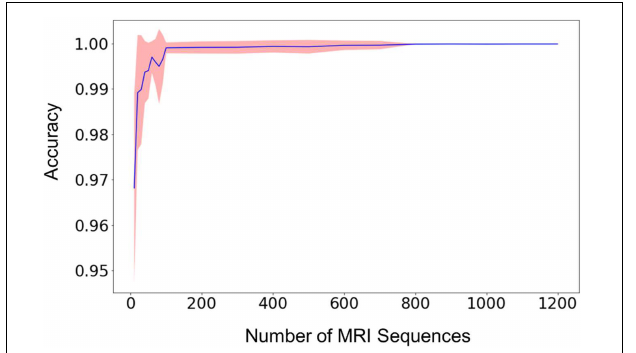
FIGURE 2 | The mean prediction accuracy (blue line) and standard deviation (shaded area around the blue line) of the random forest model built from different sizes of training datasets. The prediction accuracy is defined as the fraction of the testing scans that were classified correctly. The X-axis (i.e., Size of MRI Sequences) represents the number of scans from each type of sequence 1–7 in Table 2 , that are used in the training of the random forest model. The standard deviations are calculated from 20 independent computations. When the size reaches approximately 800, the standard deviation is smaller than the width of the line in the figure, and the prediction accuracy is consistently larger than